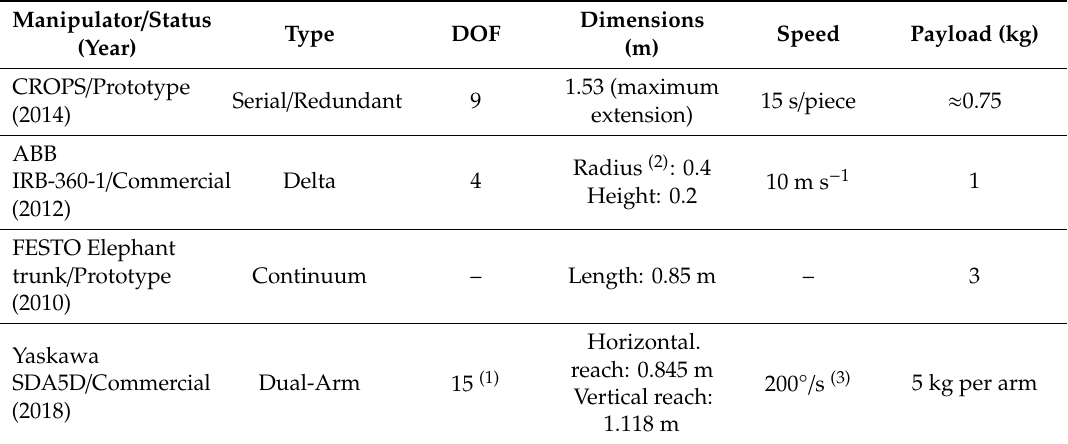
Table 4. Main characteristics of some current